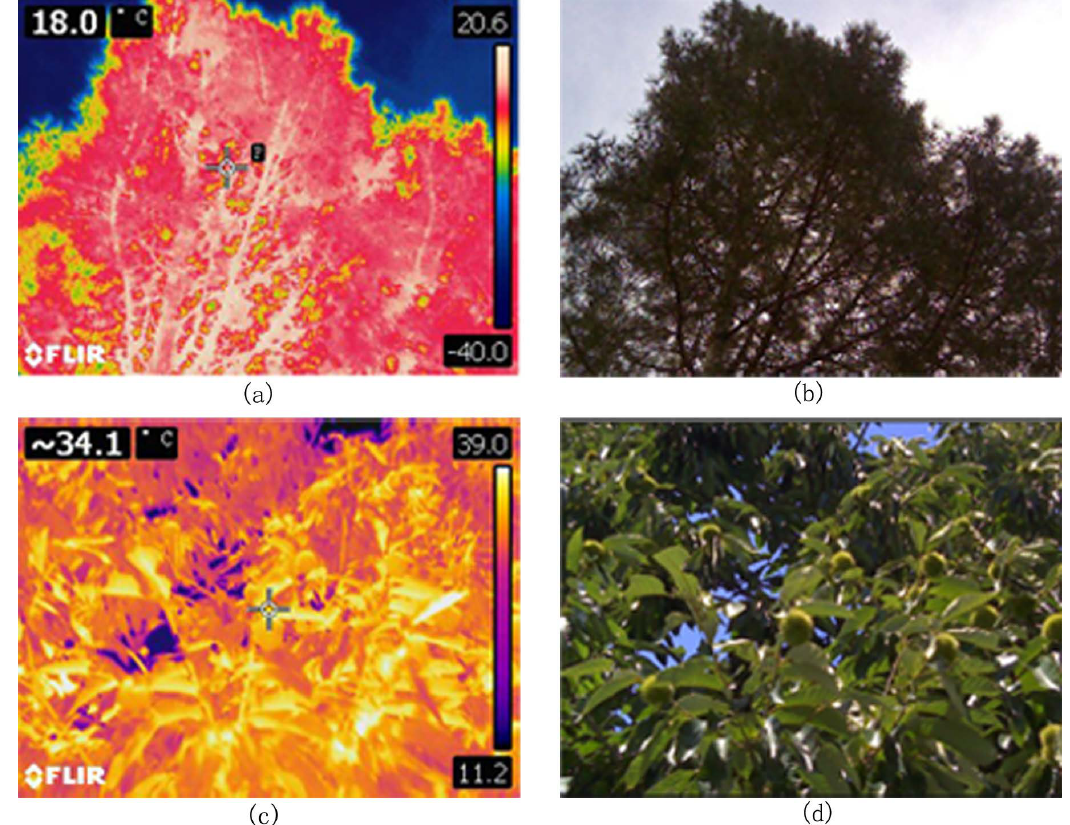
Figure 1. Thermal and visible images taken by FLIR T420 handheld thermal imager. The left column is the thermal infrared image, the right column is the corresponding visible image. ( a ) The infrared image of Pinus bungeana Zucc. et Endi taken at Beijing Forestry University; ( b ) The visible image corresponding to the thermal infrared image of ( a ); ( c ) The infrared image of Castanea mollissima Bl. taken at Yuanqiao Town; ( d ) The visible image corresponding to the thermal infrared image of ( c ). Remote Sens. 2020 , 12 , x FOR PEER REVIEW